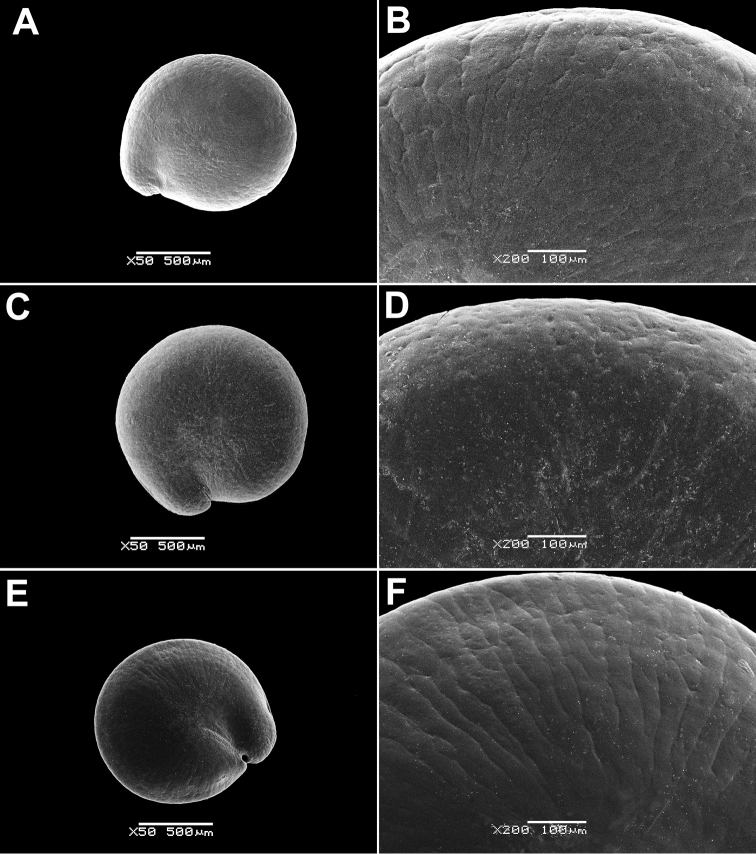
SEM micrographs of Chenopodium seeds. A, BC.novopokrovskyanumC, DC.atripliciformeE, FC.perttii. Magnification: 50× (A, C, E), 200× (B, D, F).